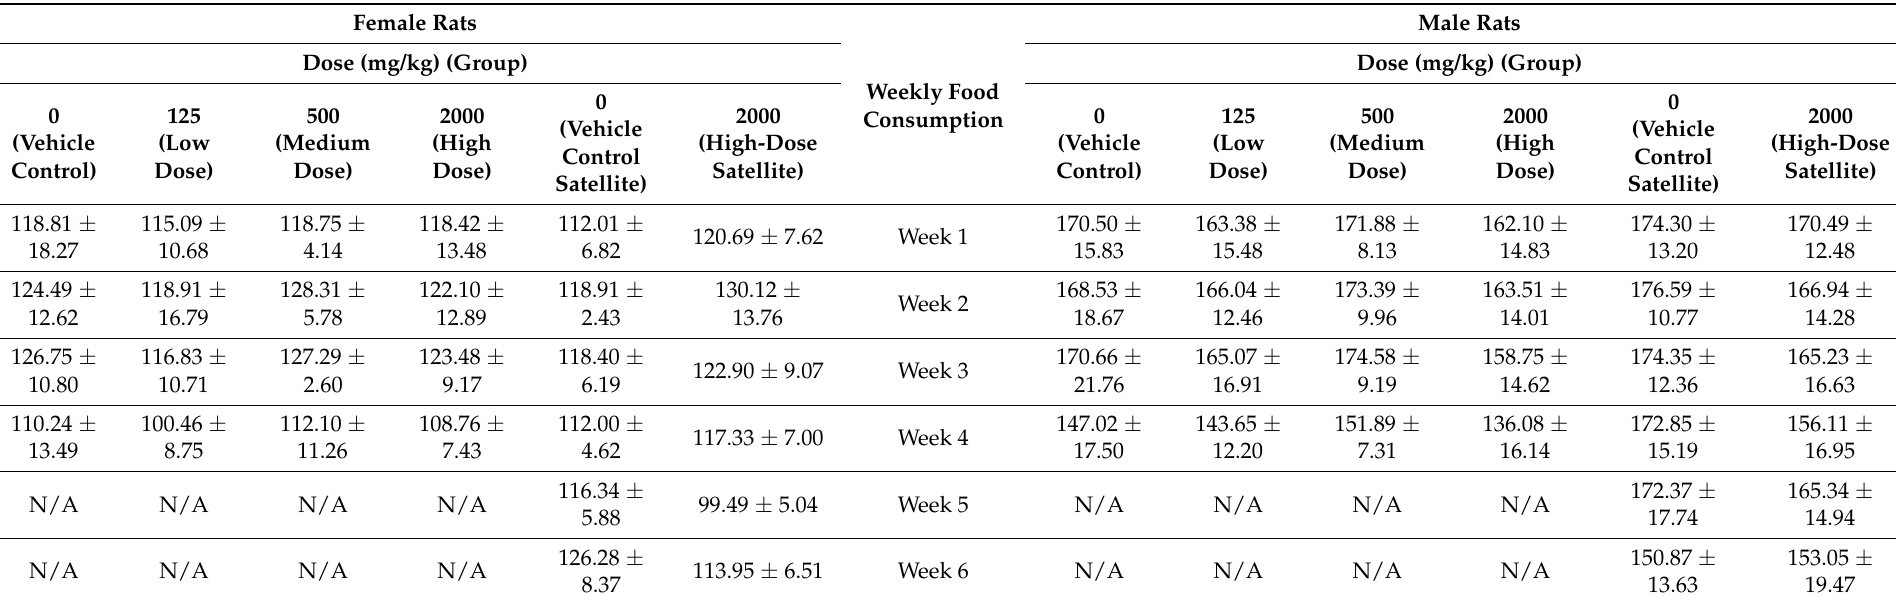
Table 4. Mean food consumption (g) in female and male